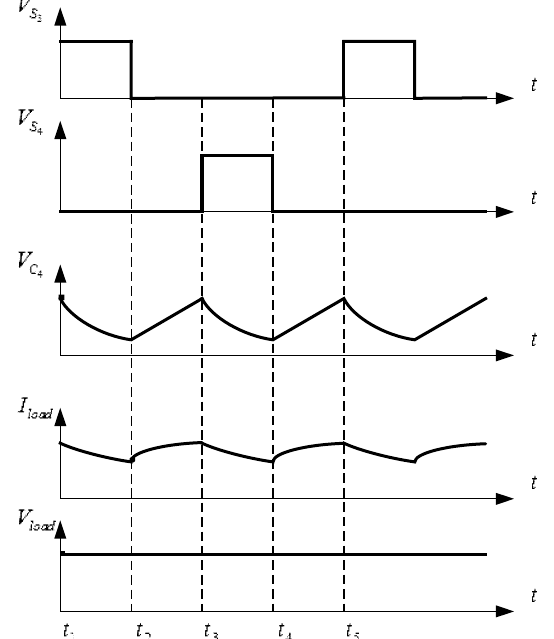
Figure 8. Principle waveforms of the voltages of the gate of power switch tubes S 3 and S 4 , the capacitor C 4 , and the voltage and current of the load R load with respect to time variation in the constant-current isolation circuit.